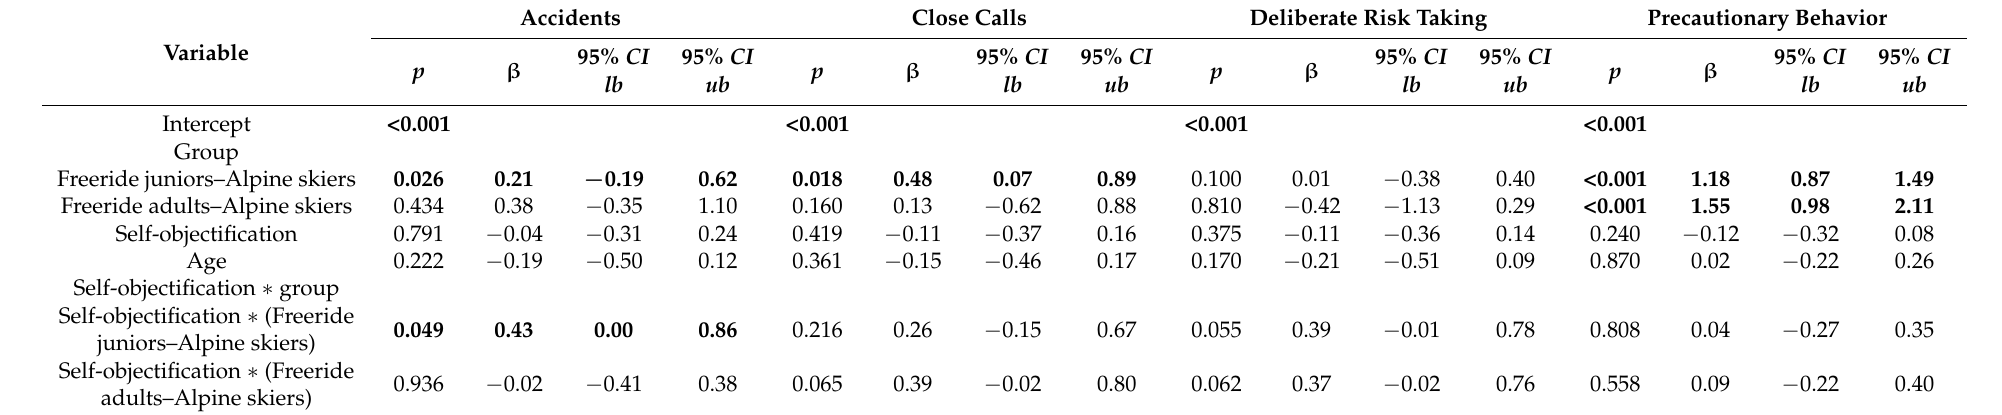
Table 3. Four separate regression analysis on the risk-related variables accidents, close calls, deliberate risk-taking and precautionary behavior as outcomes of group, self-objectification, age, and the self-objectification-by-group